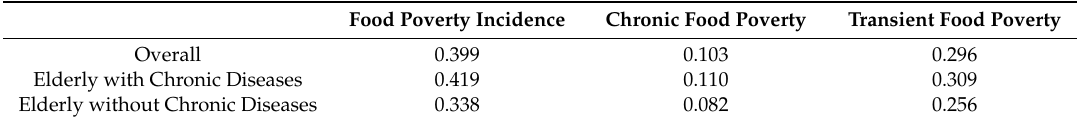
Table 2. Food poverty incidence in rural